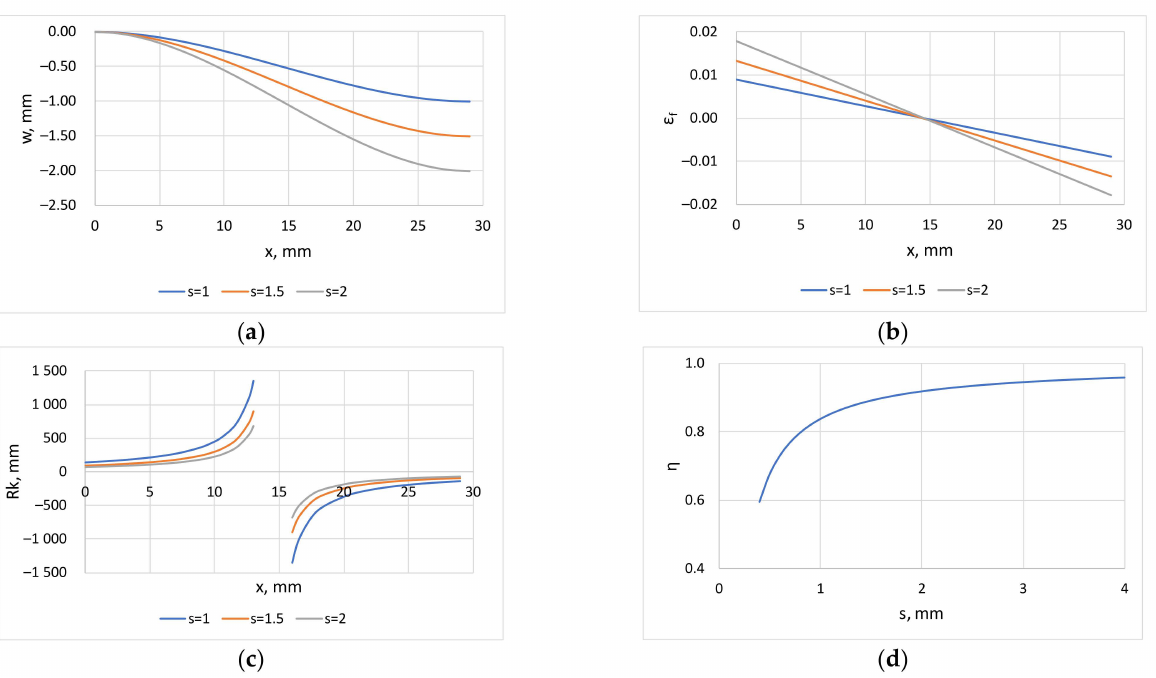
Figure 3. Characteristic parameters of roller levelling; ( a ) length deflection (Equations (11) and (13)); ( b ) strain of outer fiber (Equation (15)); ( c ) radius of curvature (Equation (16)); ( d ) ratio of plastic zone (Equation (18)).